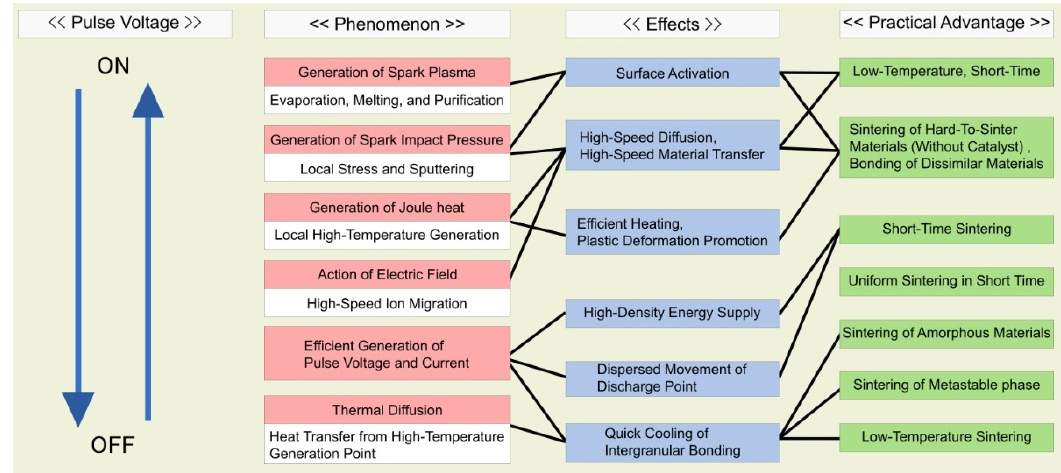
Figure 2. Effects of ON-OFF DC pulse energizing. Reprinted with permission from the InTechopen publisher [38].